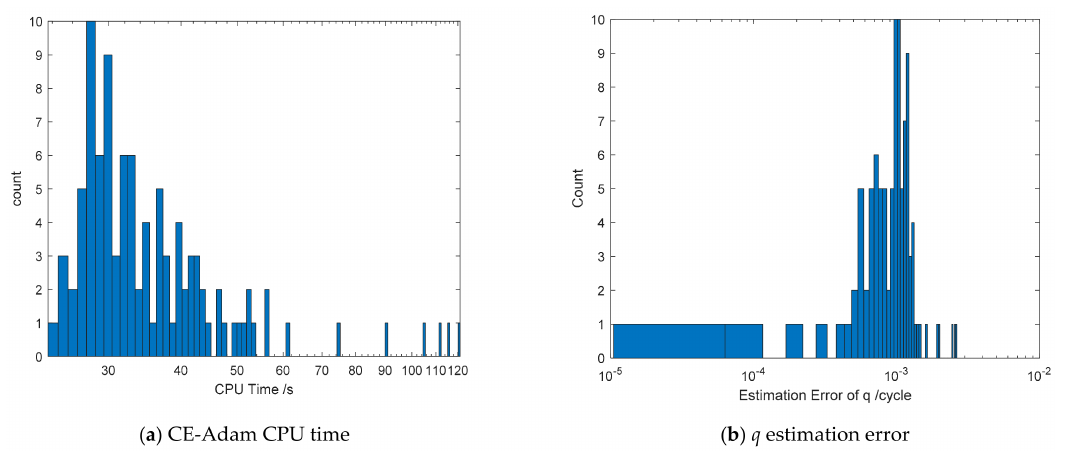
Figure 11. Crab pulsar real data